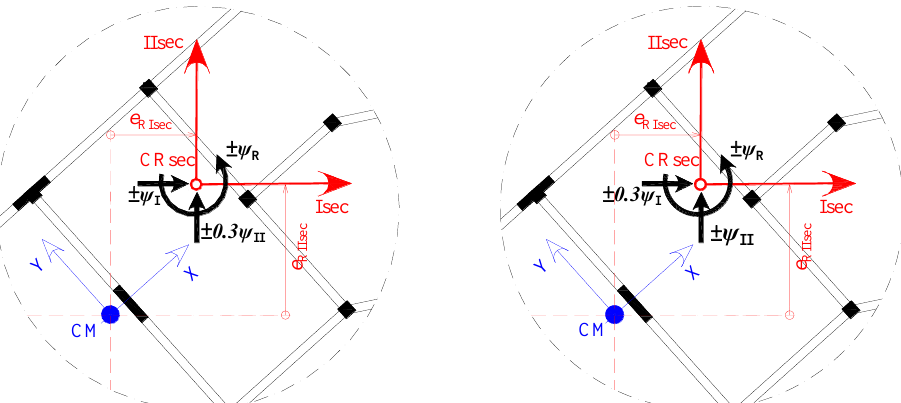
Fig. 8. Proposed Displacement-Based pushover procedure with floor enforced-displacements. (left) 8 combinations of enforced-displacements considering axis 𝛪 combinations of enforced-displacements considering axis 𝛪𝛪